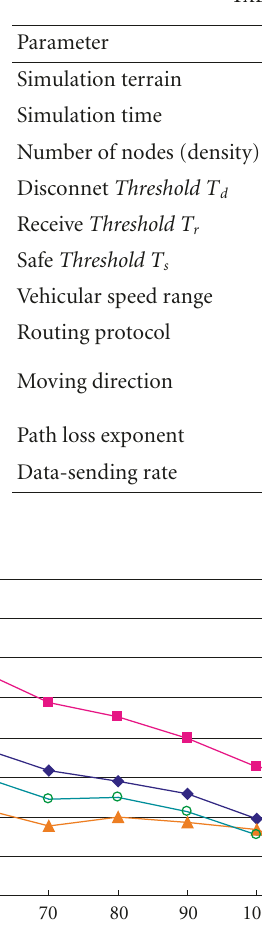
Table 1: Simulation parameters.